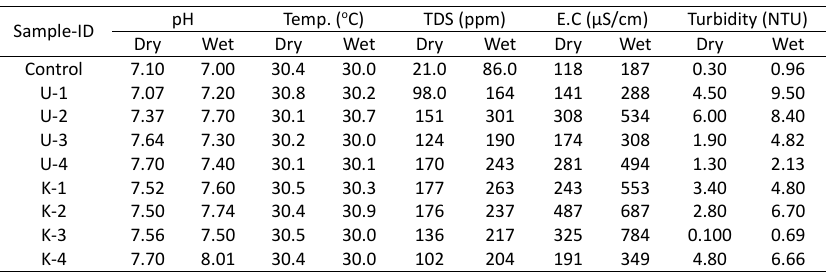
Table 1: The physical parameters of the s ample‐ID Table 2: The physical parameters of the sample-ID